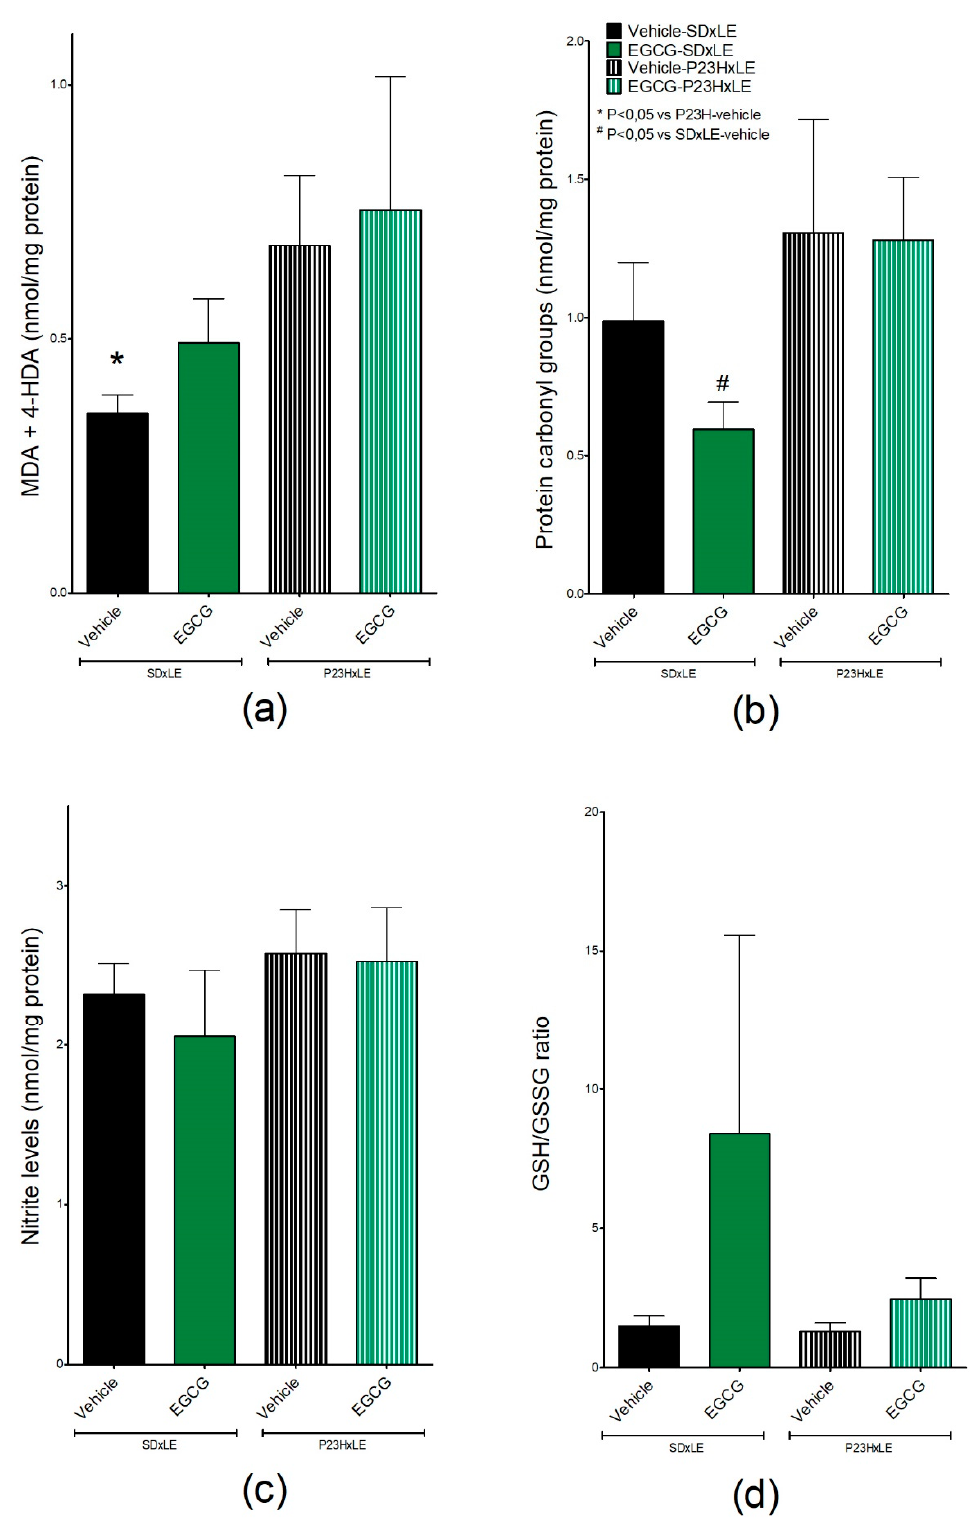
Figure 7. Levels of ( a ) malondialdehyde and 4-hidroxyalkenals (MDA and 4-had, respectively), ( b ) oxidized proteins (protein carbonyl groups), ( c ) nitrosative damage (nitrite levels), and ( d ) the ratio of reduced and oxidized glutathione (GSH / GSSG) in the liver of P23H and SD × LE treatment groups. Epigallocatequin gallate (EGCG). Data represent the mean ± standard error ( n = 5 per group). Mann–Whitney U test, * p < 0.05 versus P23H-vehicle animals, # p < 0.05 versus SD × LE animals.